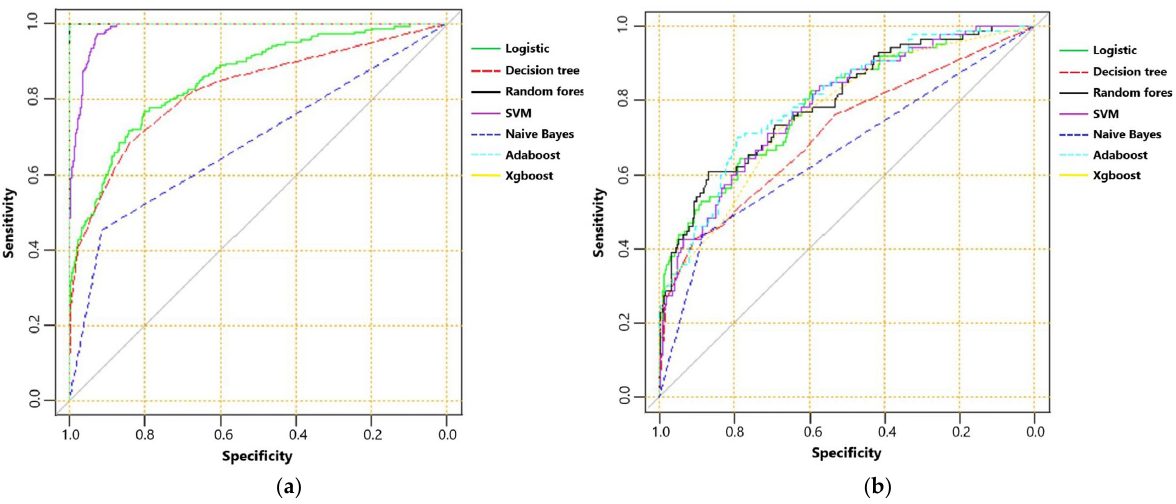
Figure 2. ( a ) The receiver operating characteristic curve of machine learning algorithms for predict- ing mortality in training set; and ( b ) receiver operating characteristic curve of machine learning algorithms for predicting mortality in testing set.